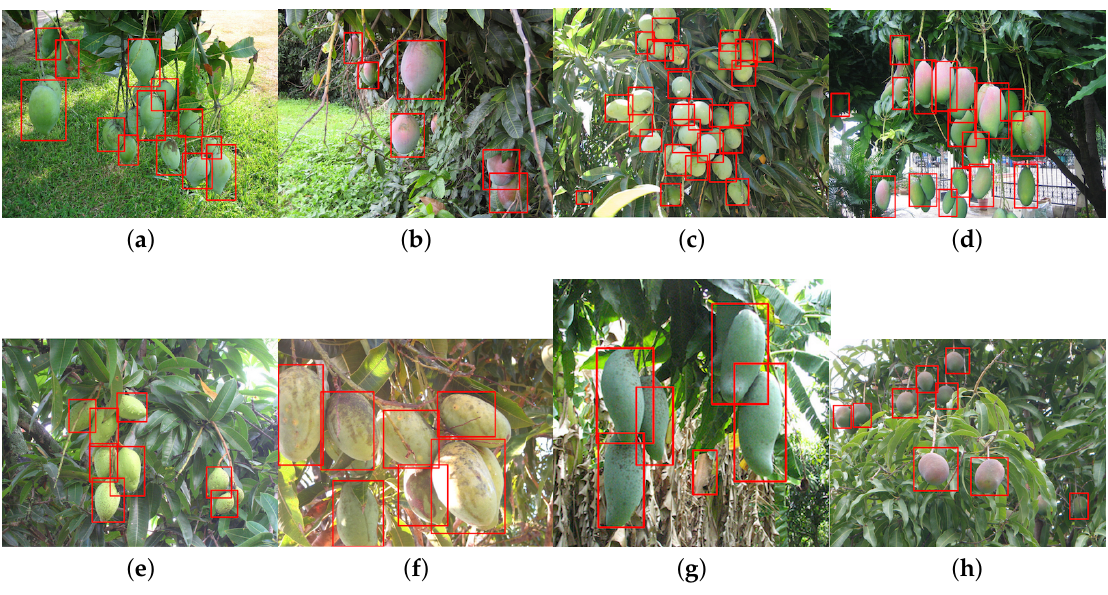
Figure 19. Eight instances ( a – g ), and ( h ) of mango detection (varying levels of ripeness). Images are obtained from Google